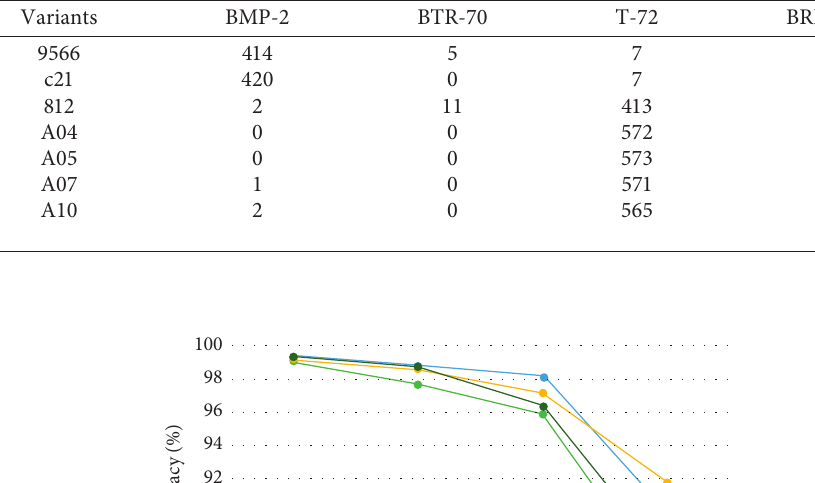
Table 8: Confusion matrix of Enhanced-shape CNN under EOC-2 (version variants).